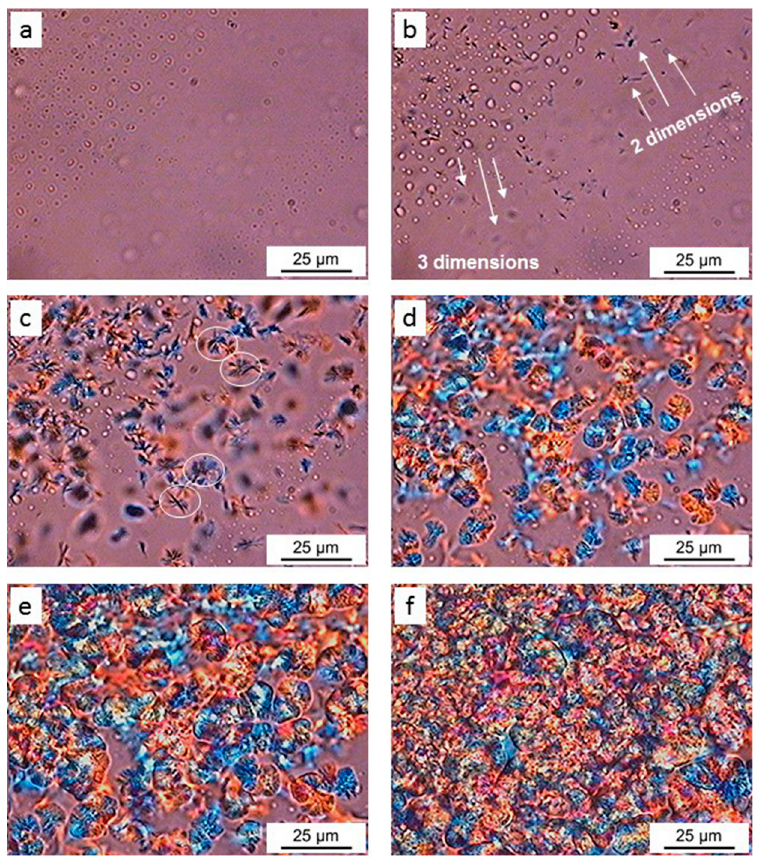
Figure 8. Polarized optical microscopy (POM) images of pure HDPE at 127 °C isotherm: ( a ) 30 s, ( b ) 2 min, ( c ) 5 min, ( d ) 8 min, ( e ) 10 min, and ( f ) 15 min.